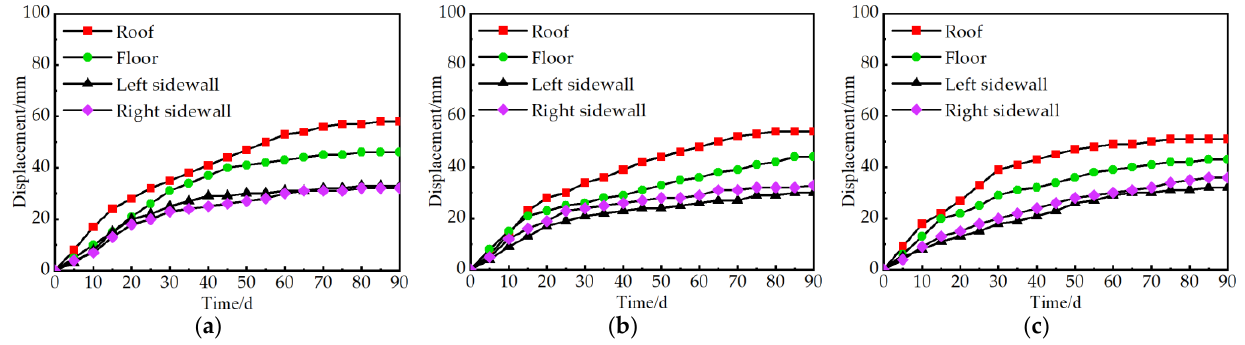
Figure 11. Surface displacement of the main roadway obtained by field observation: ( a ) #1 station curve; ( b ) #2 station curve; ( c ) #3 station curve. curve; ( b ) #2 station curve; ( c ) #3 station